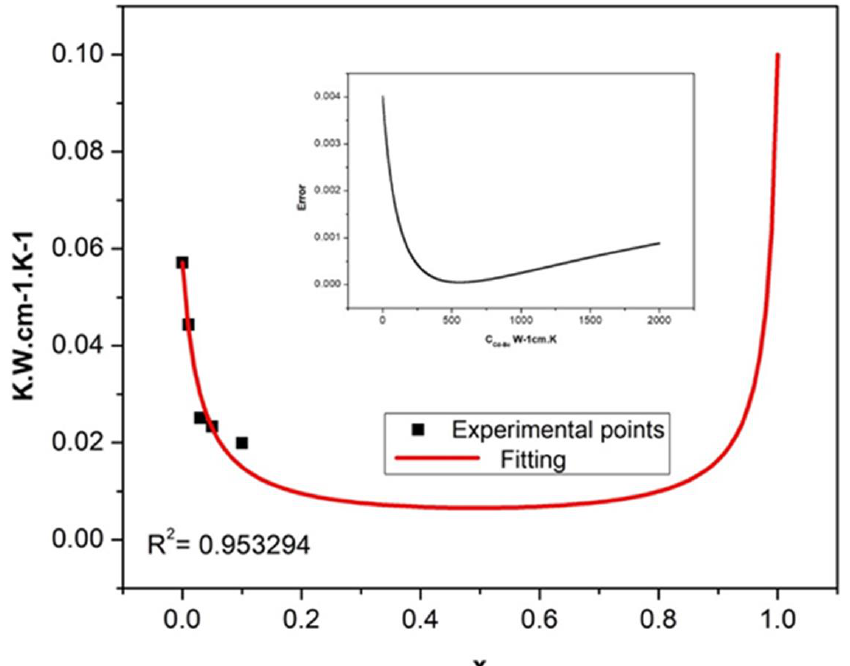
Figure 5. Thermal conductivity curve versus composition for CBT mixed crystals. The points are the experimental data, and the line is fitted and obtained using Equation (14). The error graph arising from the least square approach is presented in the inset.